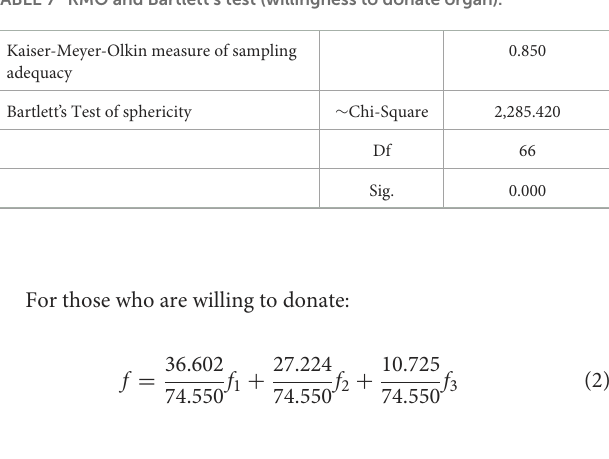
TABLE 7 KMO and Bartlett’s test (willingness to donate organ).